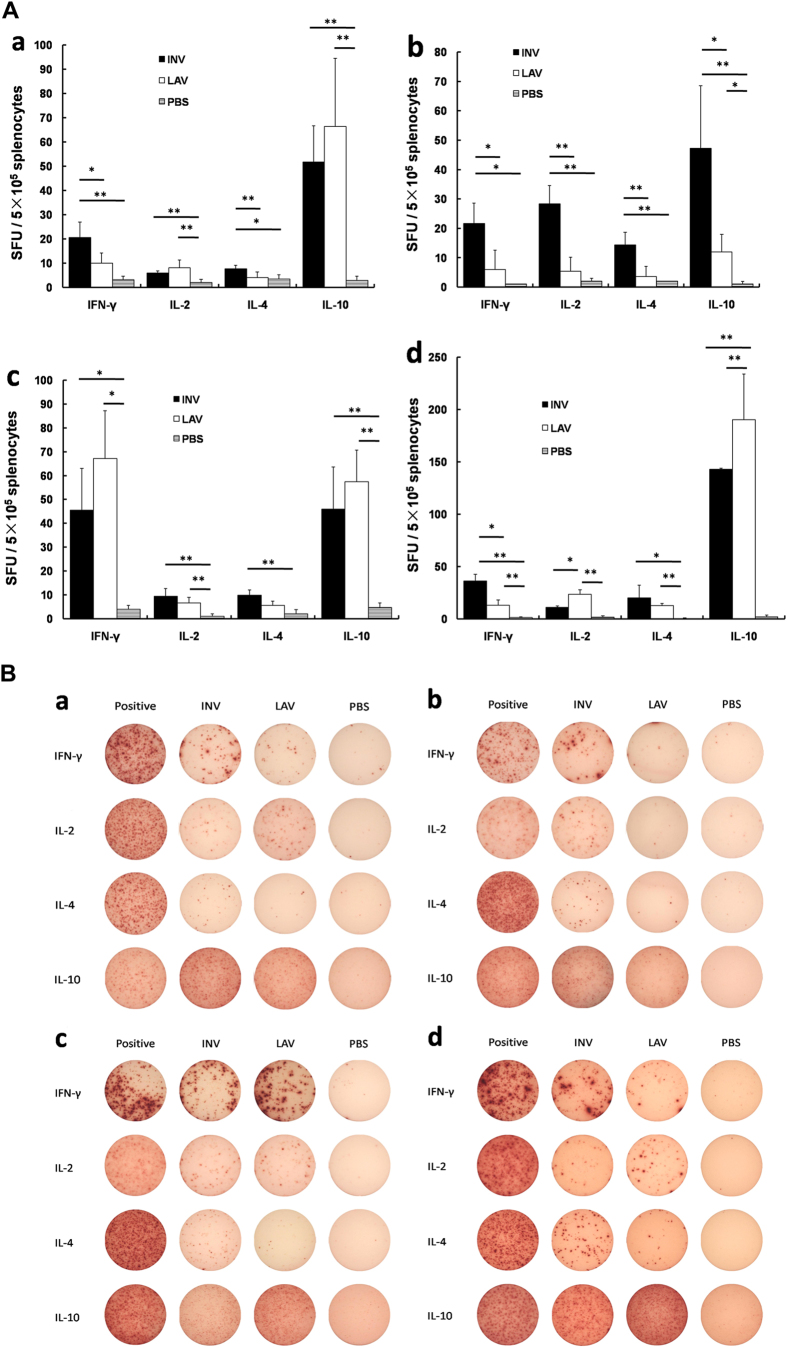
Splenocyte-secreted cytokines upon DENV1-4 antigen stimulation were detected by ELISPOT (n = 5).(A) The numbers of cytokine-positive cells are expressed as spot-forming units (SFU)/5 × 105 cells after background subtraction. (a) DENV1 antigen stimulation (*p < 0.05, **p < 0.01). (b) DENV2 antigen stimulation (*p <  0.05, **p < 0.01). (c) DENV3 antigen stimulation (*p < 0.05, **p < 0.01). (d) DENV4 antigen stimulation (*p < 0.05, **p < 0.01). (B) a representative raw ELISPOT data in the format of scanned image, a–d: stimulated by DENV1-4 antigens, respectively.